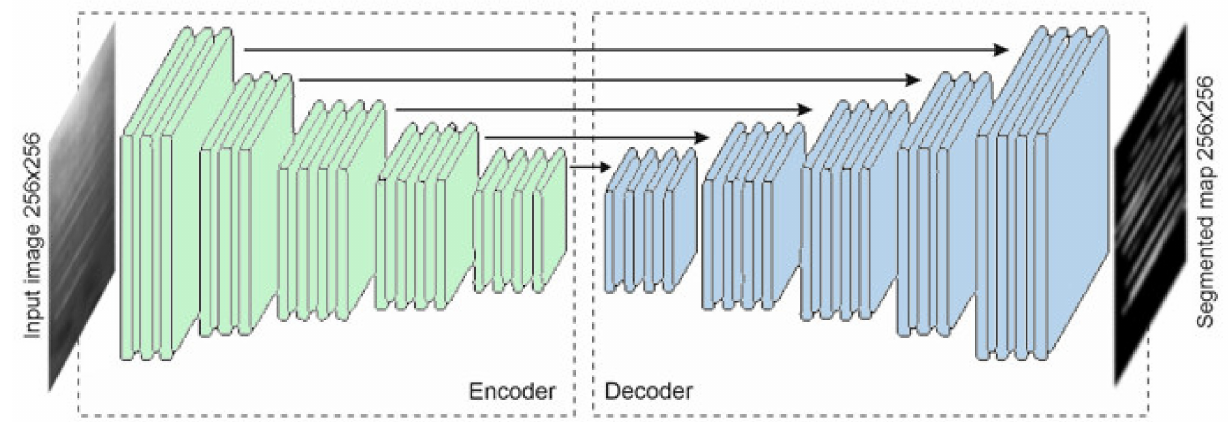
Figure 3. General architecture of the U-net-based segmentation